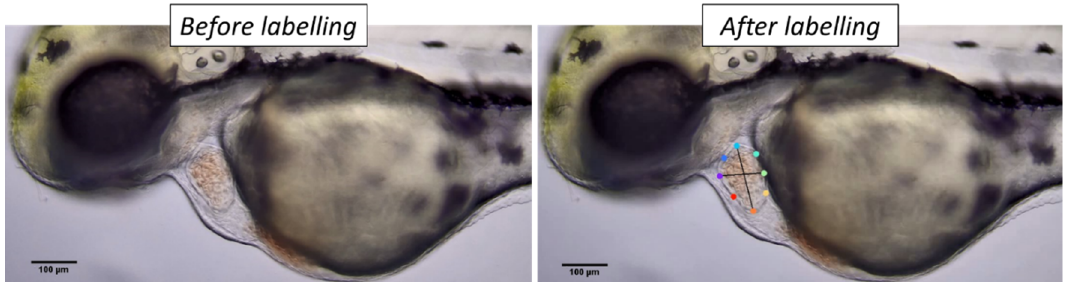
Figure A1. The ventricle area of zebrafish (day-2 post-fertilization) before and after labelling by DeepLabCut from eight different points that mark the outer heart chamber area.